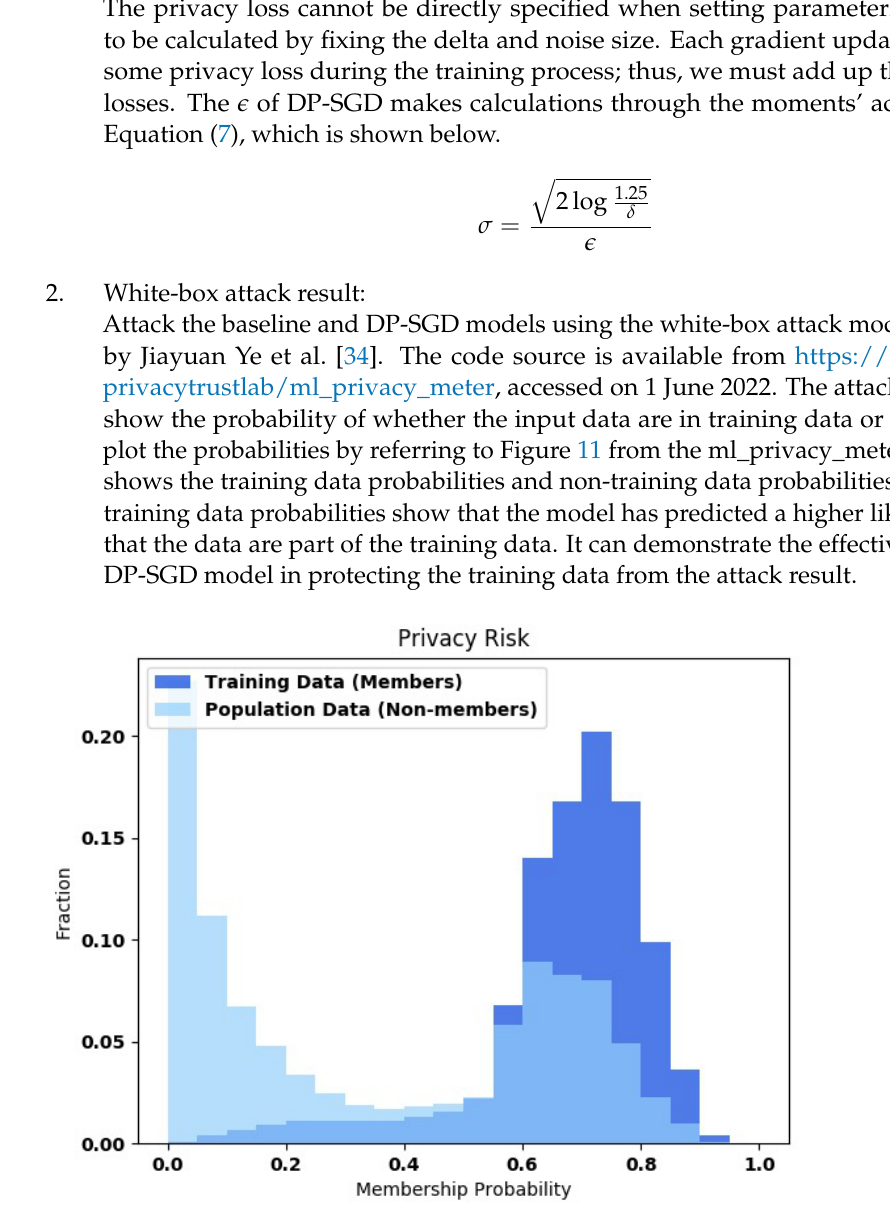
Figure 11. Example of privacy risk for training